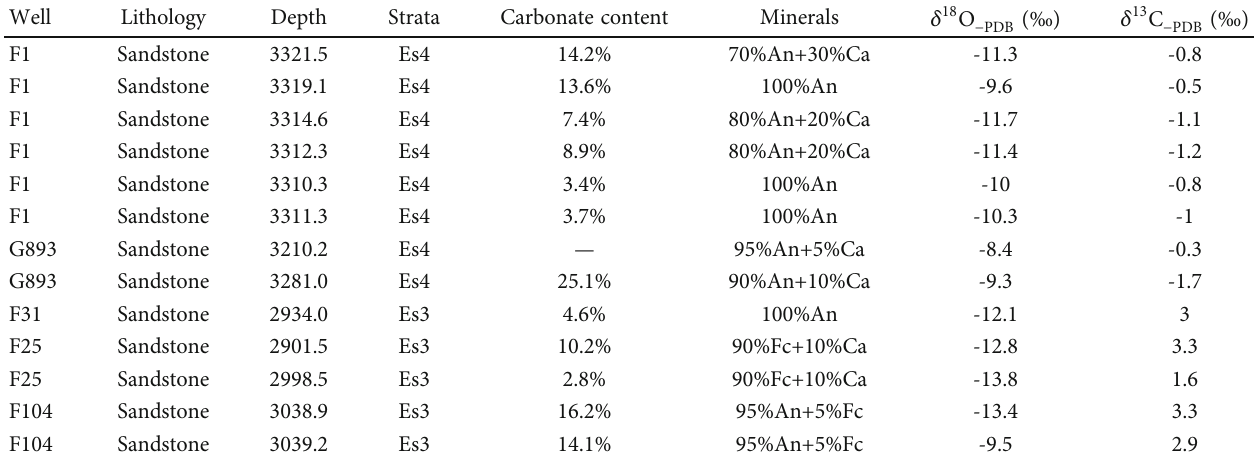
Table 3: Mineralogical and isotopic composition of carbonate. Ca: calcite; Fc: Fe-calcite; An: ankerite.